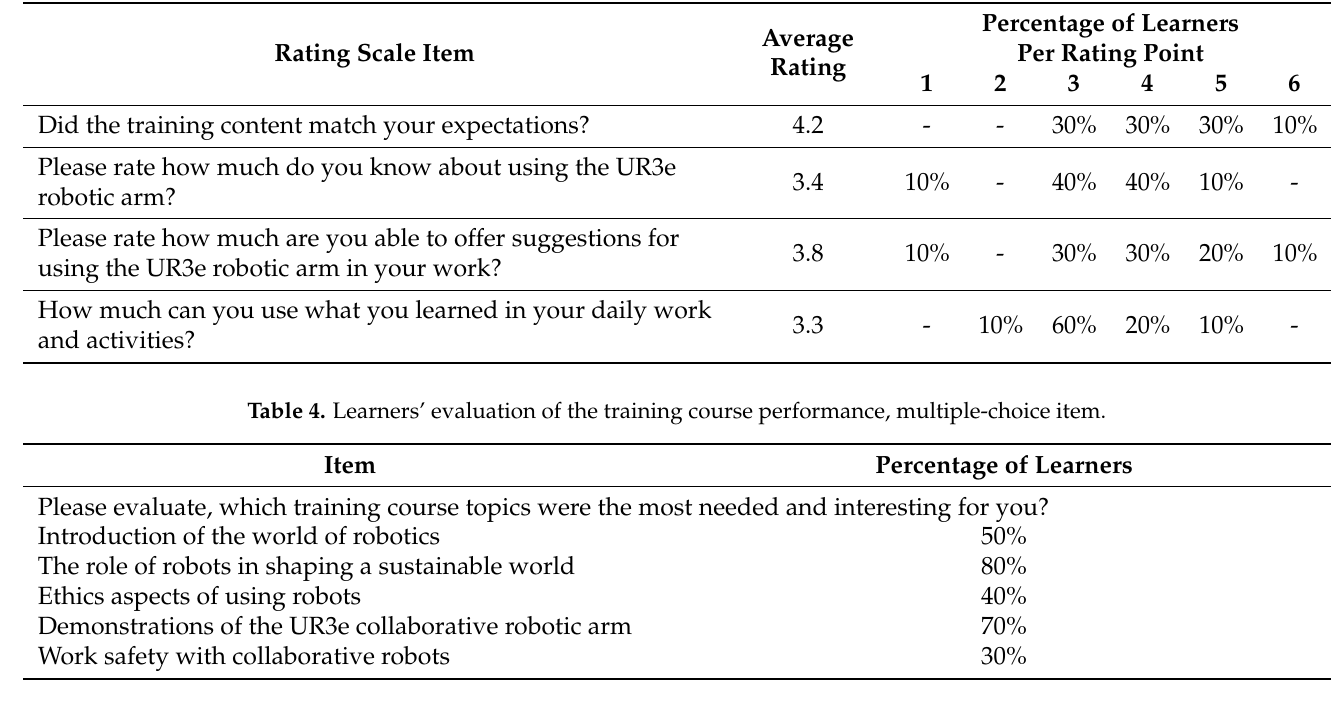
Table 3. Learners’ evaluation of the training course performance, rating-scale items.